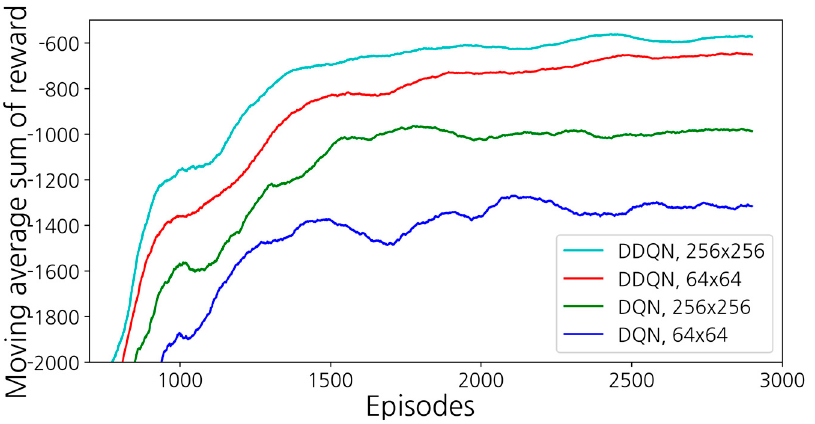
Figure 12. Training results according to SARL’s RL algorithm and deep learning network structure when random flows are generated in topology 2.